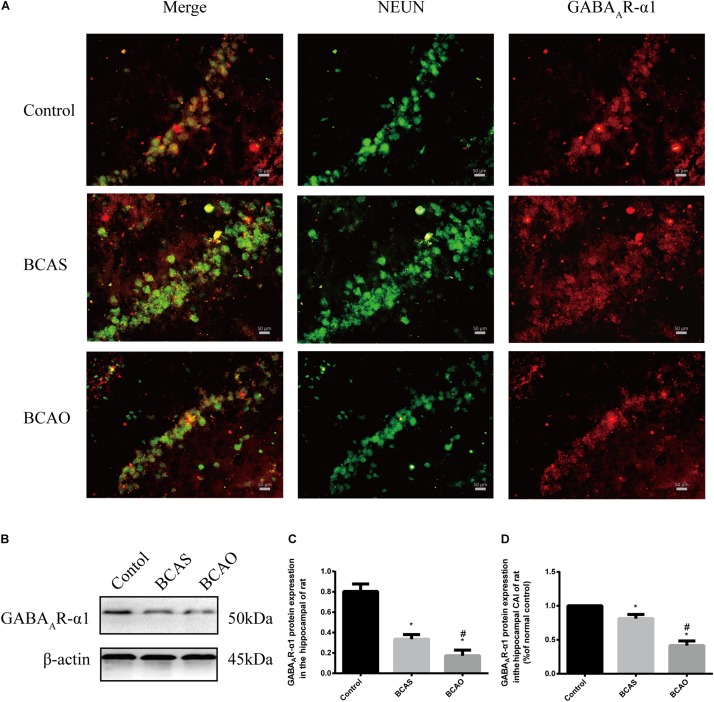
GABAAR-α1 expression in the hippocampal CA1 area at 30 days after surgery. Protein detected by immunofluorescence (A and C). GABAAR-α1 expression in the rat hippocampus detected by western blotting (B and D). Data are expressed as the mean ± SD (n = 6/group). ∗P < 0.05 compared with the control group; #P < 0.05 compared with the BCAS group. BCAS, bilateral common carotid artery stenosis; BCAO, bilateral common carotid artery occlusion; GABAAR-α1, gamma-aminobutyric acid receptor subunit α1; SD, standard deviation.